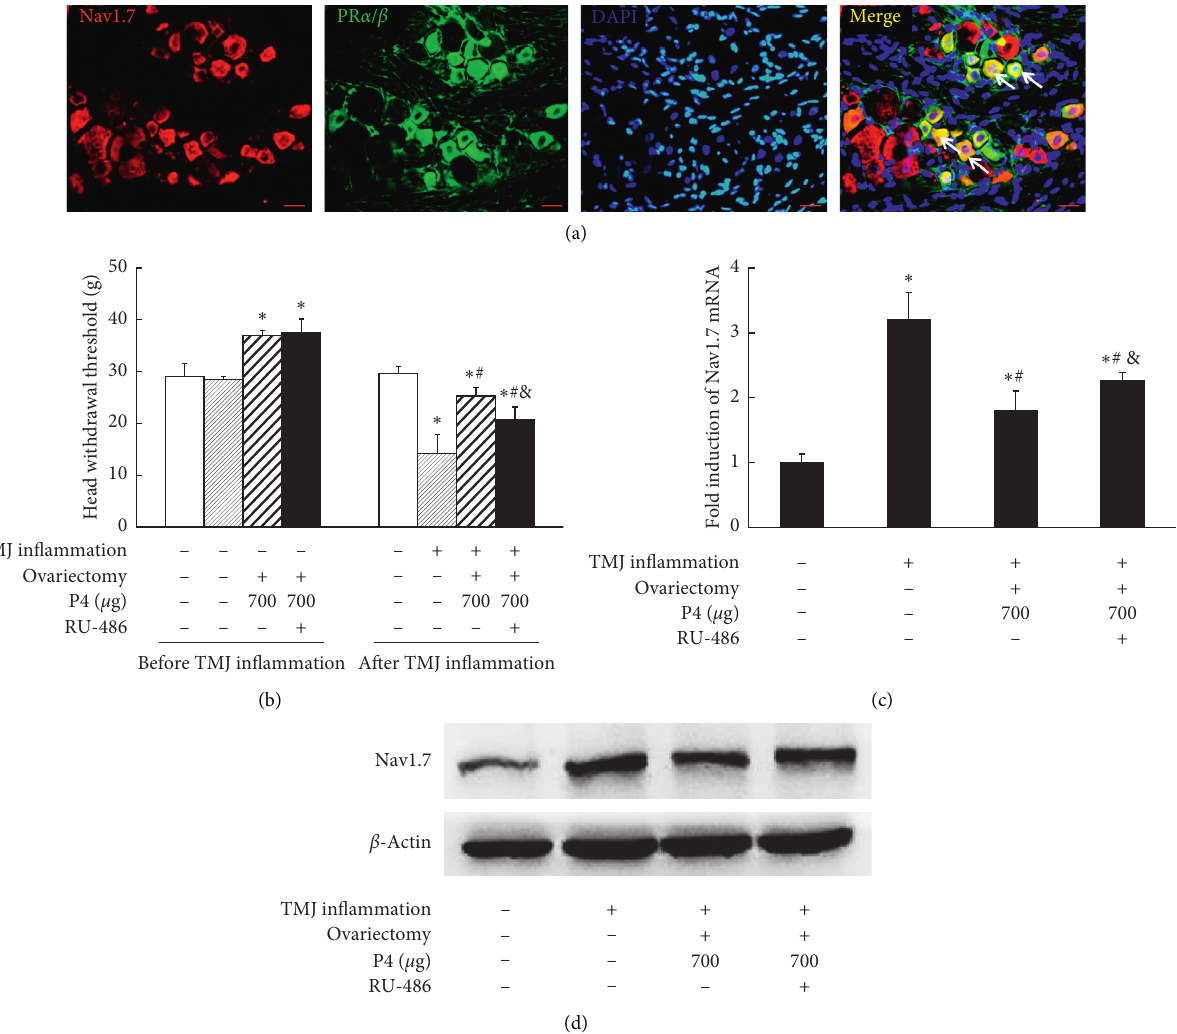
Figure 4: Blocking progesterone receptors partially reversed the effect of P4 on TMJ hyperalgesia and Nav1.7 expression. (a) Representative immunofluorescence of Nav1.7 and PR α / β in TG. There was colocalization between Nav1.7 and PR α / β (yellow, indicated by arrow) in TG neurons, bars � 20 μ m. (b) Head withdrawal threshold. RU486 partially inhibited the repressive effect of P4 on head withdrawal threshold. (c) Real-time PCR analysis for Nav1.7 expression in TG. After induction of TMJ inflammation, Nav1.7 mRNA expression was significantly increased in the sham rats, and 700 μ g P4 partially repressed TMJ inflammation-induced Nav1.7 mRNA expression. RU486 partially inhibited the repressive effect of P4 on Nav1.7 mRNA expression. (d) Representative immunoblotting for Nav1.7 expression in TG. Nav1.7 protein expression corresponded to the mRNA expression pattern. β -Actin served as an internal control for equal loading. ∗ P < 0 . 05 versus the control group; # P < 0 . 05 versus the sham group; & P < 0 . 05 versus 700 μ g P4 without the RU486 group. Data are expressed as mean ± SD.